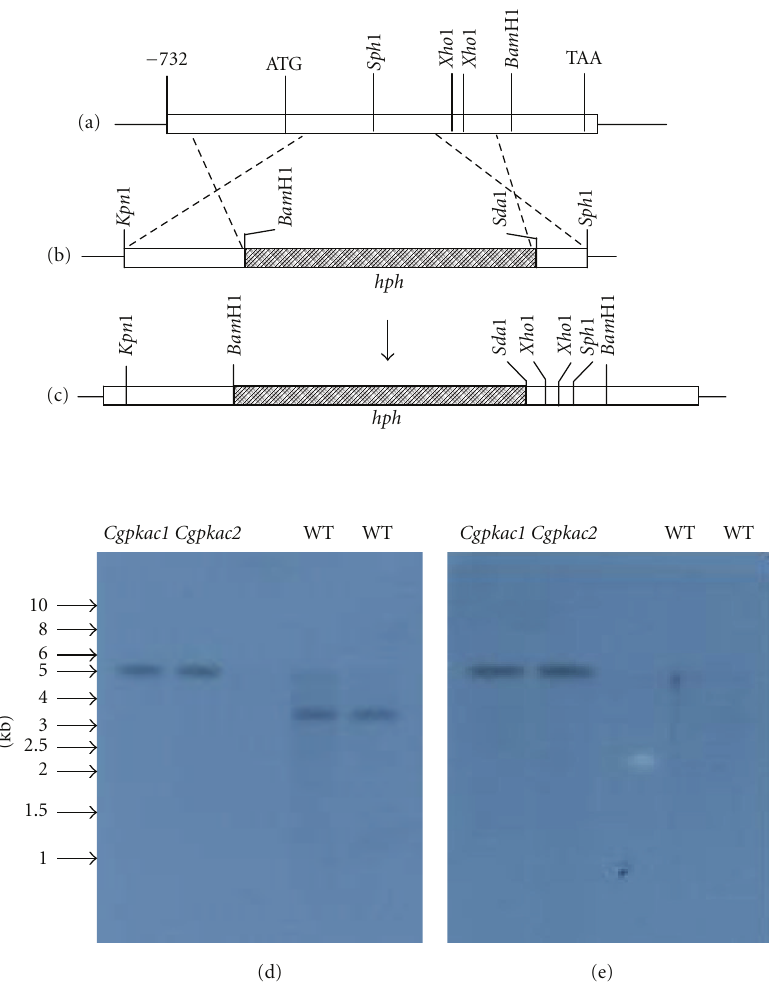
Figure 3: Schematic presentation of CgPKAC gene disruption and DNA blot analysis of CgPKAC gene replacement. (a) Predicted restriction map of the CgPKAC locus in the C. gloeosporioides genome. (b) Gene replacement vector pN-CPKA. The dotted line between (a) and (b) represents the crossing over between two homologous regions that may occur during CgPKAC gene disruption. (c) Predicted restriction map of the Cgpkac deleted allele. (d) Genomic DNA was digested with Xho 1 and probed with a 695bp of 5 (cid:3) CgPKAC fragment. (e) Genomic DNA was digested with Xho 1 and probed with a 1.1 kb of hph fragment. In the wild type, a single 3.5 kb DNA fragment was detected whilst for the transformants Cgpkac1 and Cgpkac2 , a 5.8kb band was identified when probed with CgPKAC . Only the Cgpkac1 and Cgpkac2 transformants showed positive signals when probed with the hph